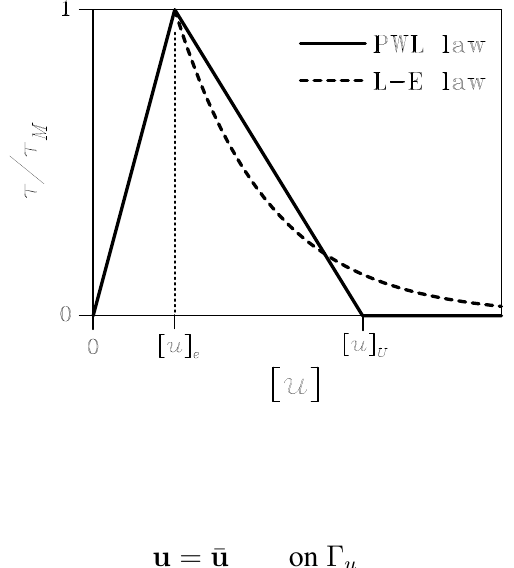
Figure 2. Piecewise linear (PWL) and linear-exponential (L-E) effective traction- displacement discontinuity